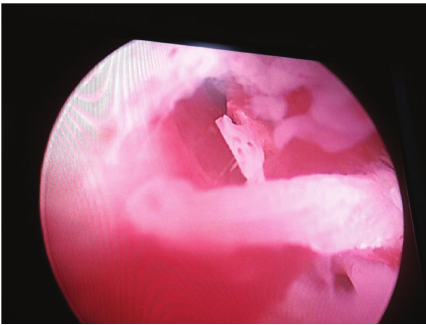
Figure 2: Hysteroscopic view of the uterus.